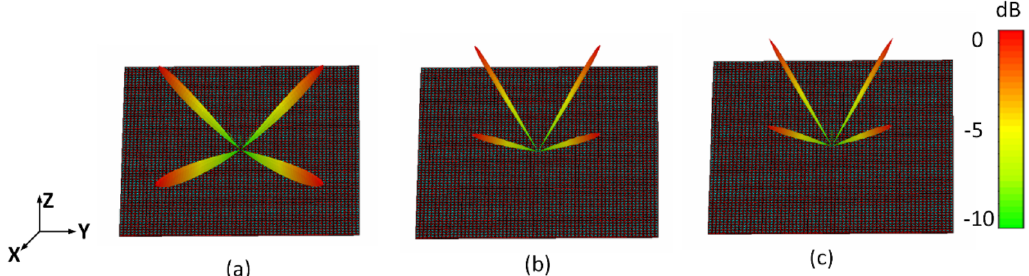
Fig. 8. Normalized E-pattern of Metasurface II at (a) 1.30 THz, (b) 1.50 THz, (c) 1.70 THz. when the chemical potential is